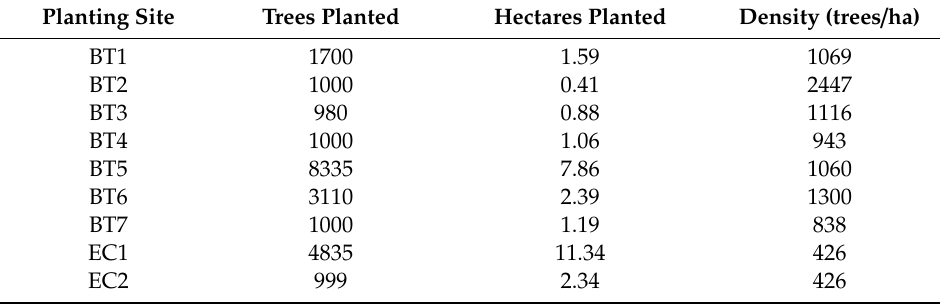
Table 2. Descriptions of planting sites (BT = Beartooth, EC = East Centennial, WC = West Centennial, WI = Wind River, WY = West Yellowstone). Initial planting density trees per hectare (TPH). Planting